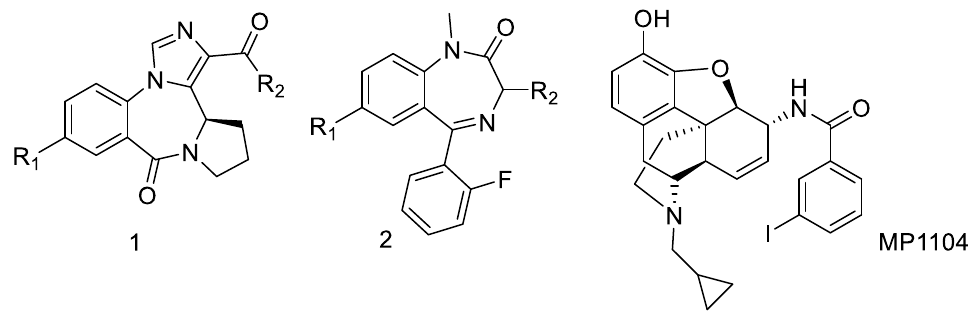
Figure 1. Benzodiazepine compound series and opioid receptor agonist MP1104.